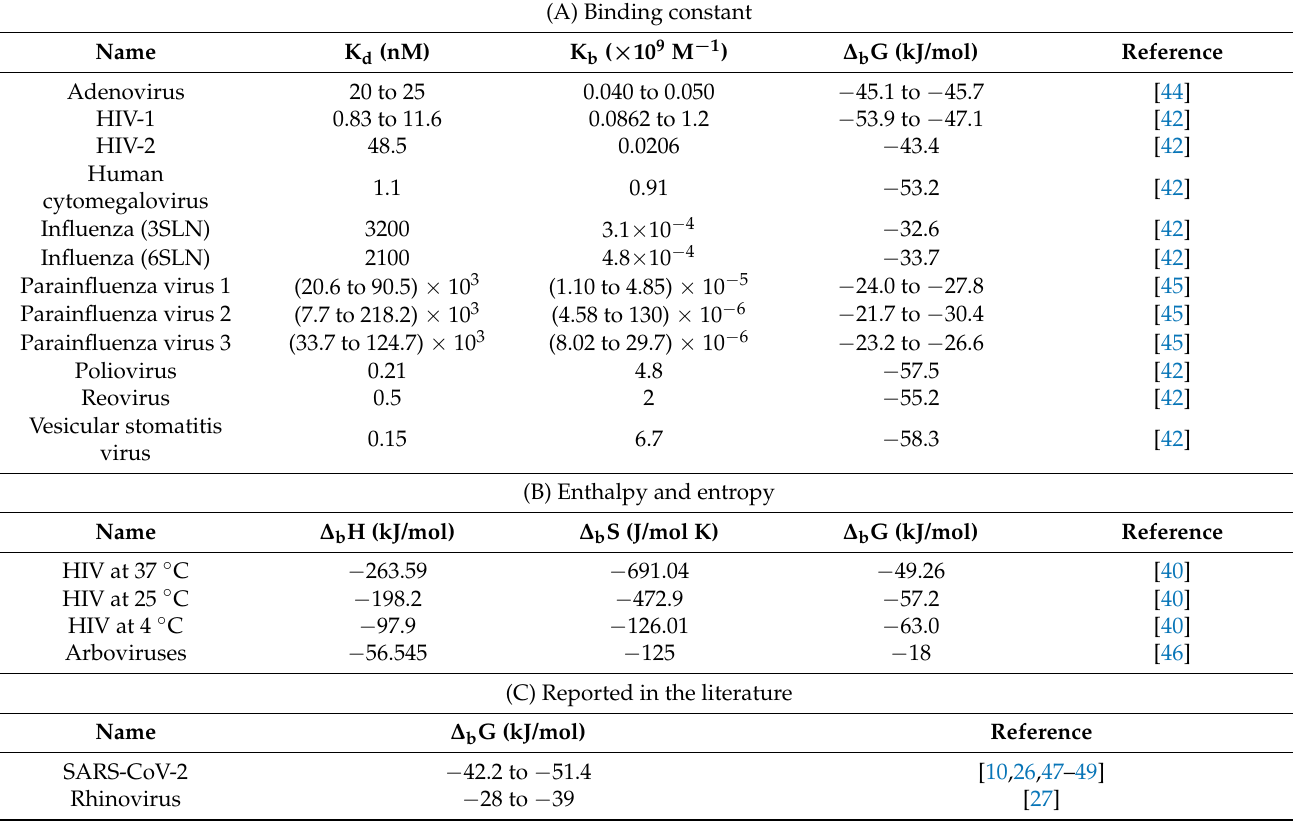
Table 1. Gibbs energies of binding of viruses. Part (A): Gibbs energies of binding calculated from dissociation constants. The “Reference” column gives sources from which the dissociation constants were taken. Part (B): Gibbs energies of binding calculated from enthalpies and entropies of binding. The “Reference” column gives sources from which the ∆ b H and ∆ b S values were taken. Part (C): Gibbs energies of binding reported in the literature and references from which they were taken. Symbols: K d —dissociation constant; K b —binding affinity; ∆ b G—Gibbs energy of binding; ∆ b G—enthalpy of binding; ∆ b S—entropy of